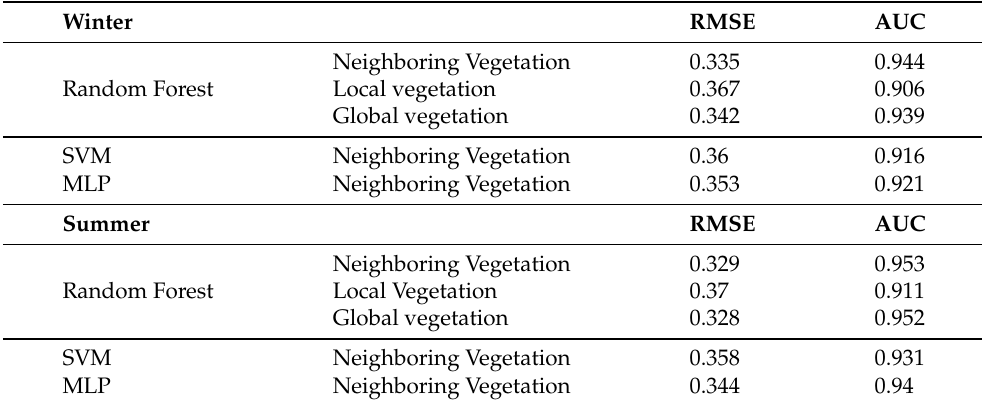
Table 2. RMSE and AUC values for testing burned area, for both winter and summer, and for all the implemented